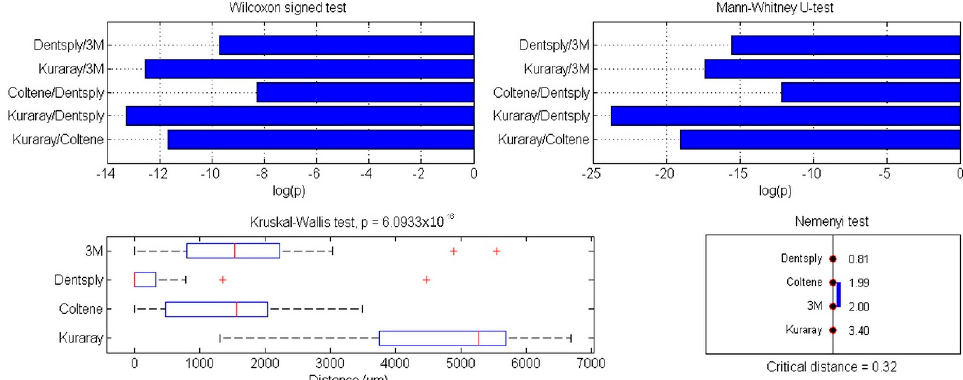
Figure 8. The Wilcoxon signed rank test shows significant difference between Dentsply “Prime and Bond Active” and 3M ( z = − 4.011), Kuraray “Clearfil Universal Bond Quick” and 3M ESPE “Single bond” ( z = 4.638), Coltene “One Coat 7 Universal” and Dentsply “Prime and Bond Active” ( z = 3.655), Kuraray “Clearfil Universal Bond Quick” and Dentsply “Prime and Bond Active” ( z = 4.782), and Figure 8. Results of statistical analysis using the Wilcoxon signed rank test, Mann–Whitney U-test, Kuraray “Clearfil Universal Bond Quick” and Coltene “One Coat 7 Universal” ( z = 4.453) adhesive Kruskal–Wallis test and Nemenyi test (Dentsply “Prime and Bond Active”, 3M ESPE “Single bond”, bonds (all p < 0.001). The results were confirmed by the Mann–Whitney U-test, also showing Coltene “One Coat 7 Universal”, and Kuraray “Clearfil Universal Bond Quick”).